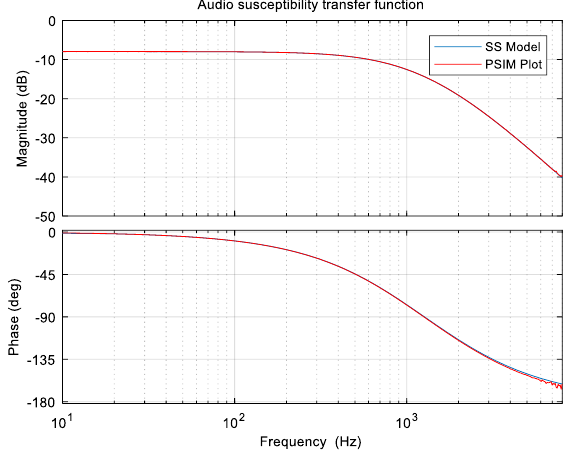
Figure 21. Audio − susceptibility transfer function for a Voltage − fed full bridge converter.